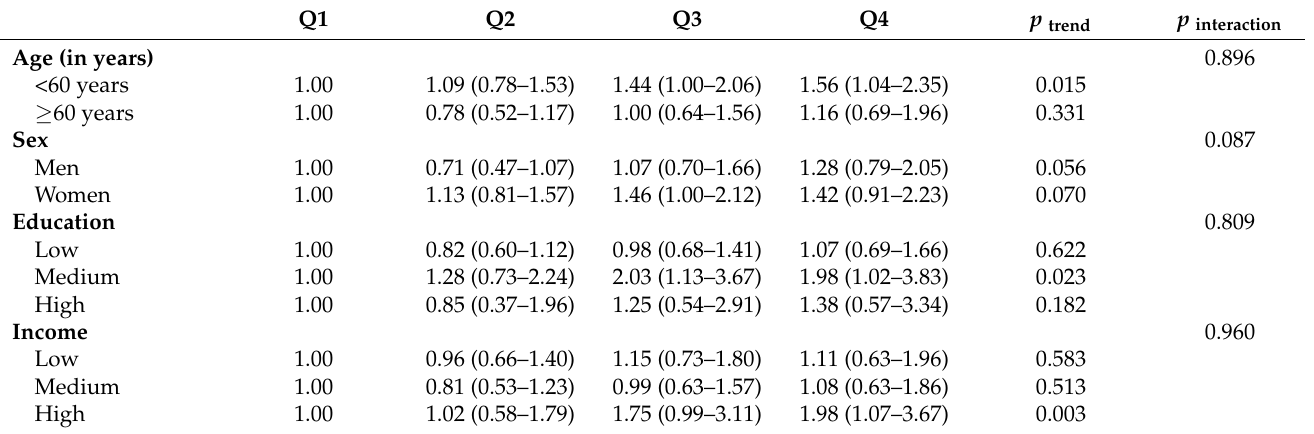
Table 3. Subgroup analyses of the association between quartiles of animal methionine intake and